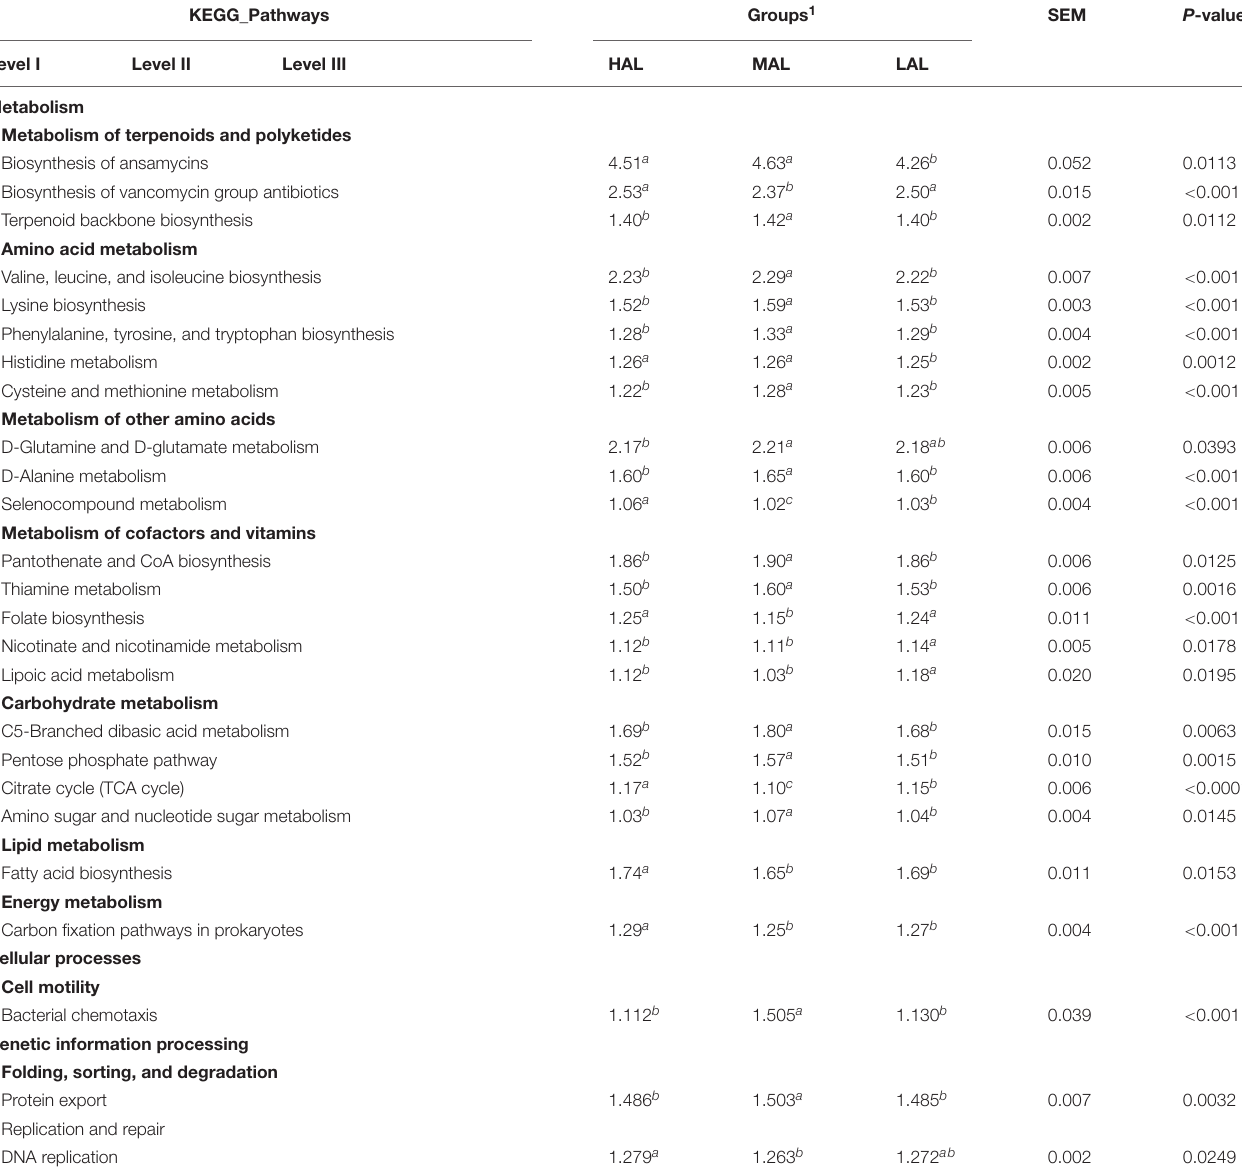
TABLE 3 | Functional predictions for rumen microbiota in yaks inhabiting regions located at distinct altitudes; only significantly different KEGG pathways are shown. KEGG_Pathways Groups